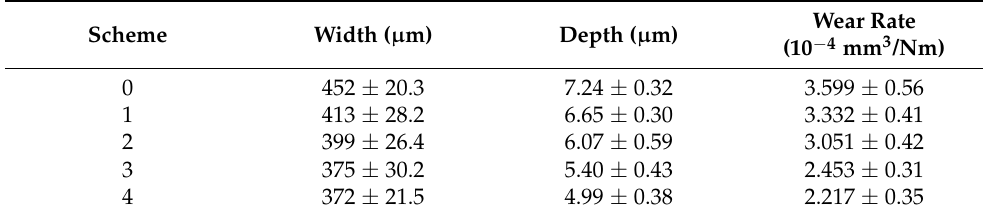
Table 2. Wear properties of AM alloy.